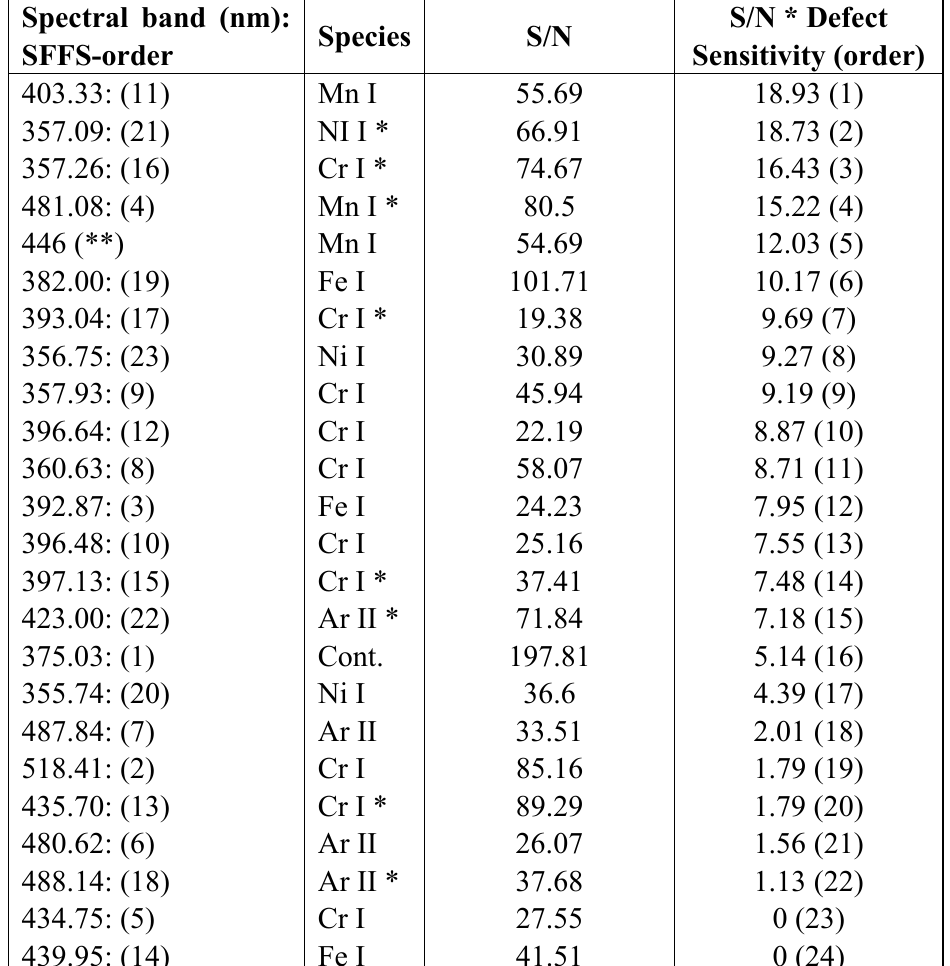
Table 2. Spectral bands selected and listed by SFFS and reordered by S/N Defect